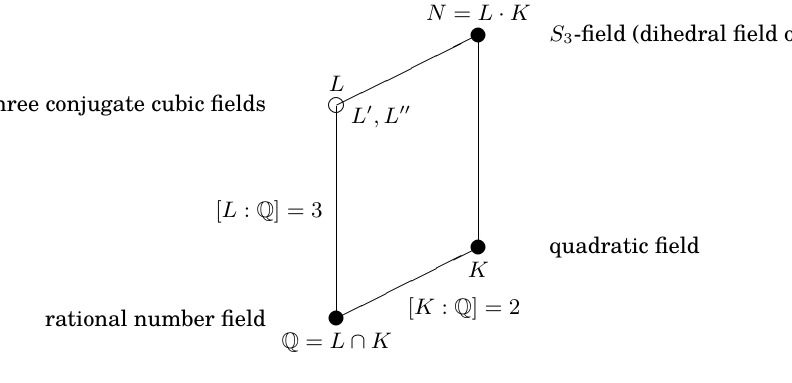
Figure 5: Hasse subfield diagram of the normal closure N/ Q of L